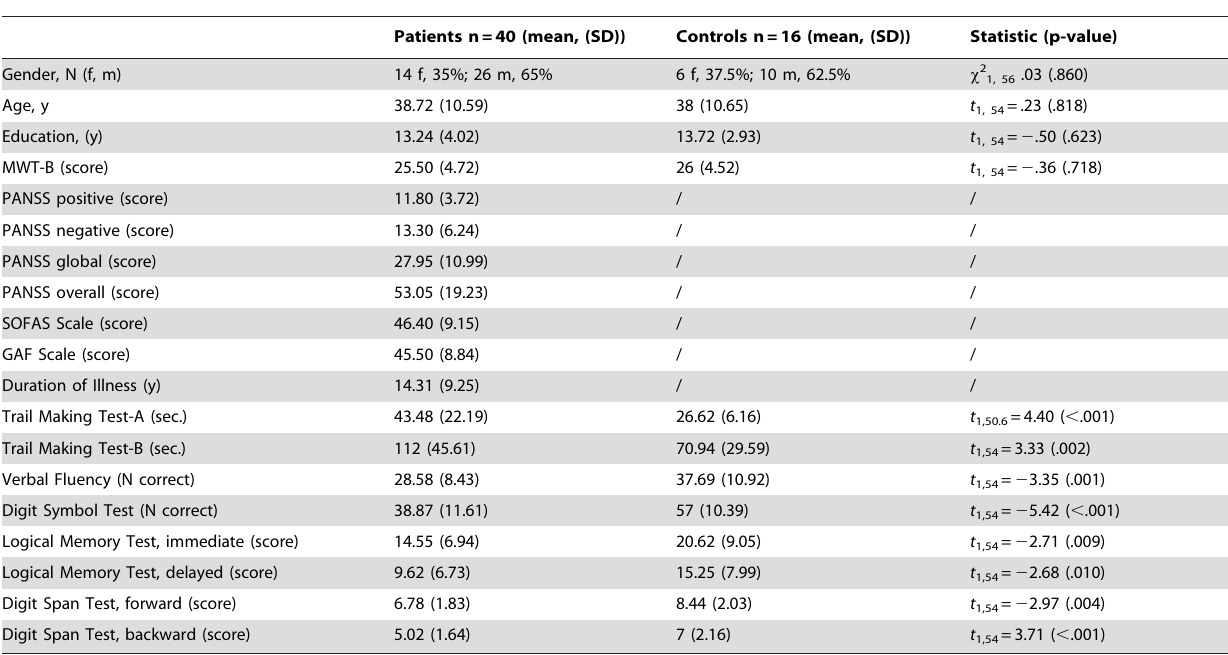
Table 1. Demographic, clinical and neuropsychological characteristics of schizophrenia patients and healthy controls.